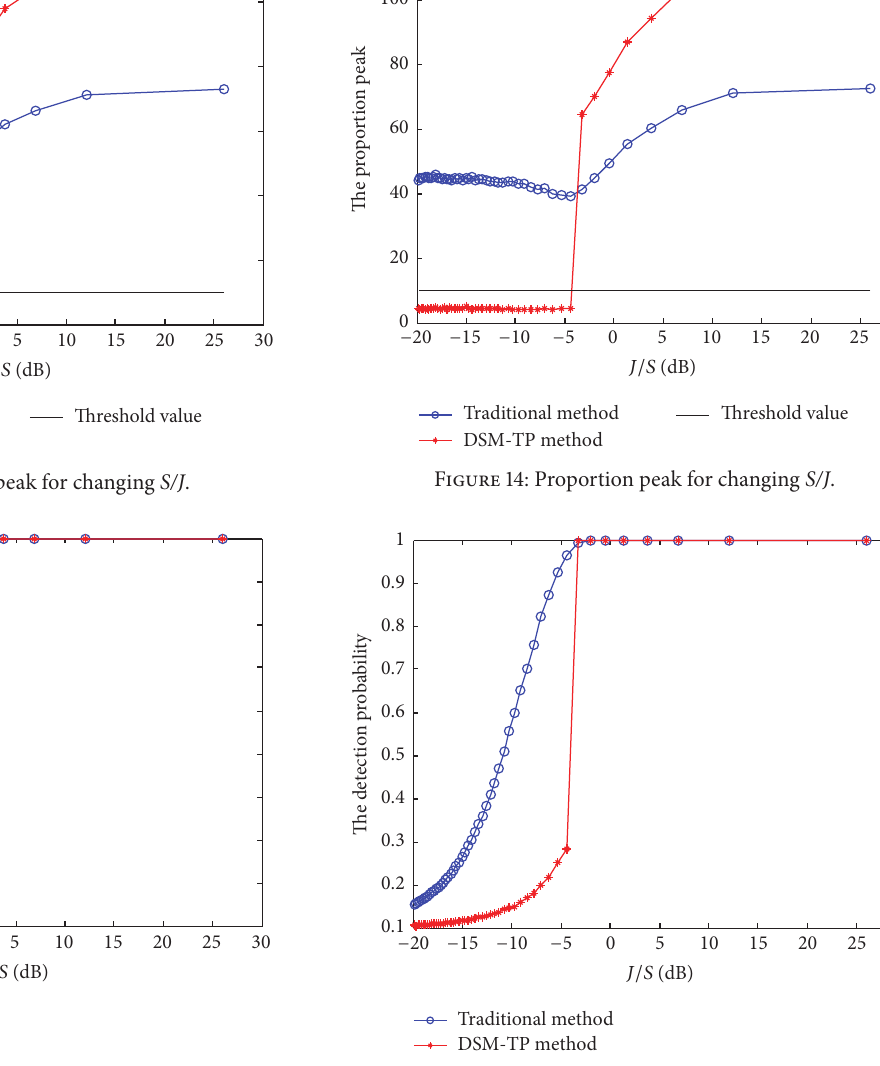
Figure 13: Detection probability for changing S/J .